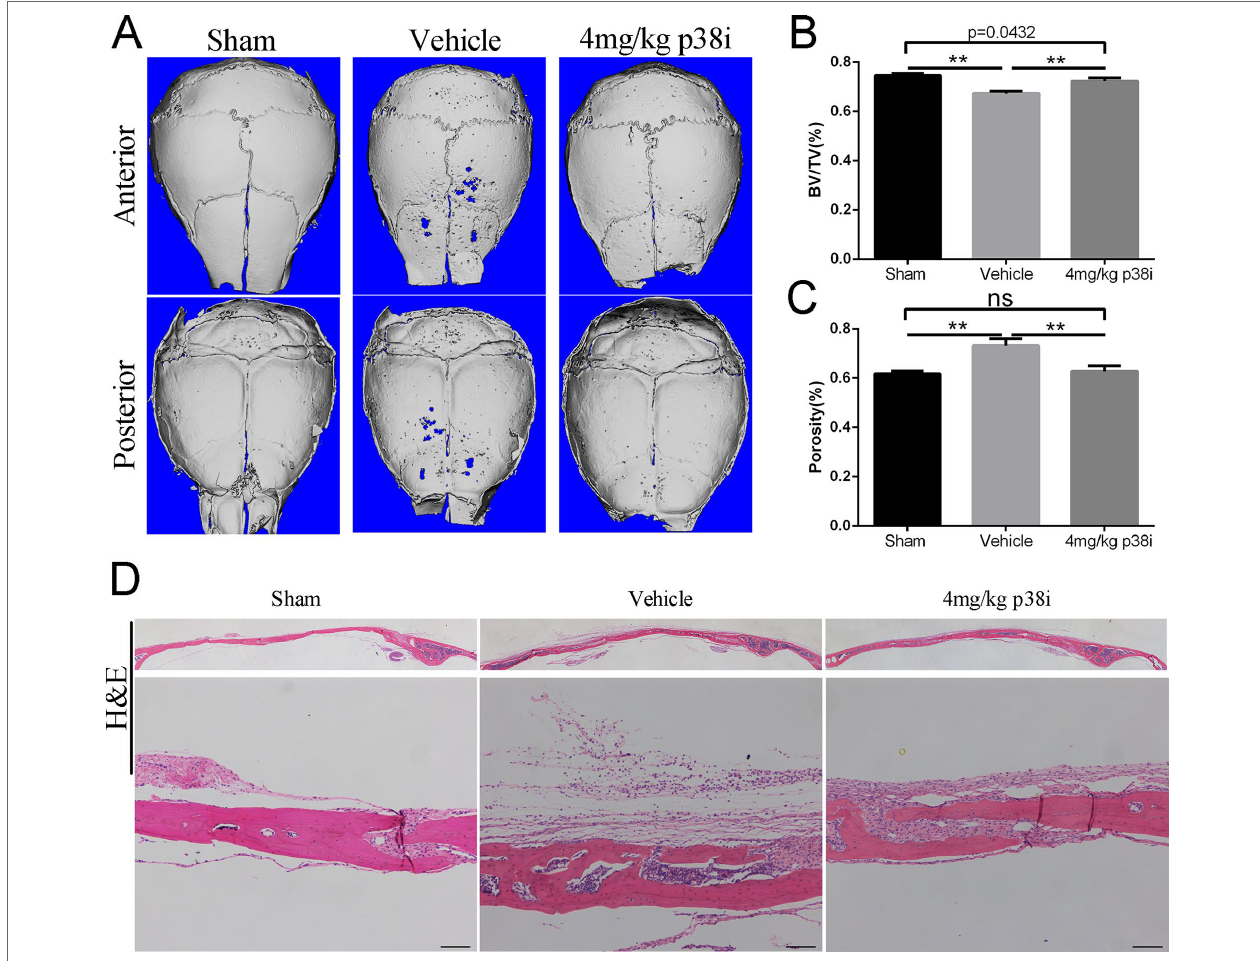
FIGURE 4 | Administration of SB239063 prevents LPS-induced osteolysis in vivo. (A) Representative micro-CT and 3D reconstructed images were obtained for each group. (B) The BV/TV and (C) porosity of each sample were measured. The results were normalized to the sham group. (D) Effect of SB239063 on mouse LPS-induced calvarial osteolysis was accessed with H&E staining. Scale bars, 100 μm. *P < 0.05, **P < 0.01, ***P <